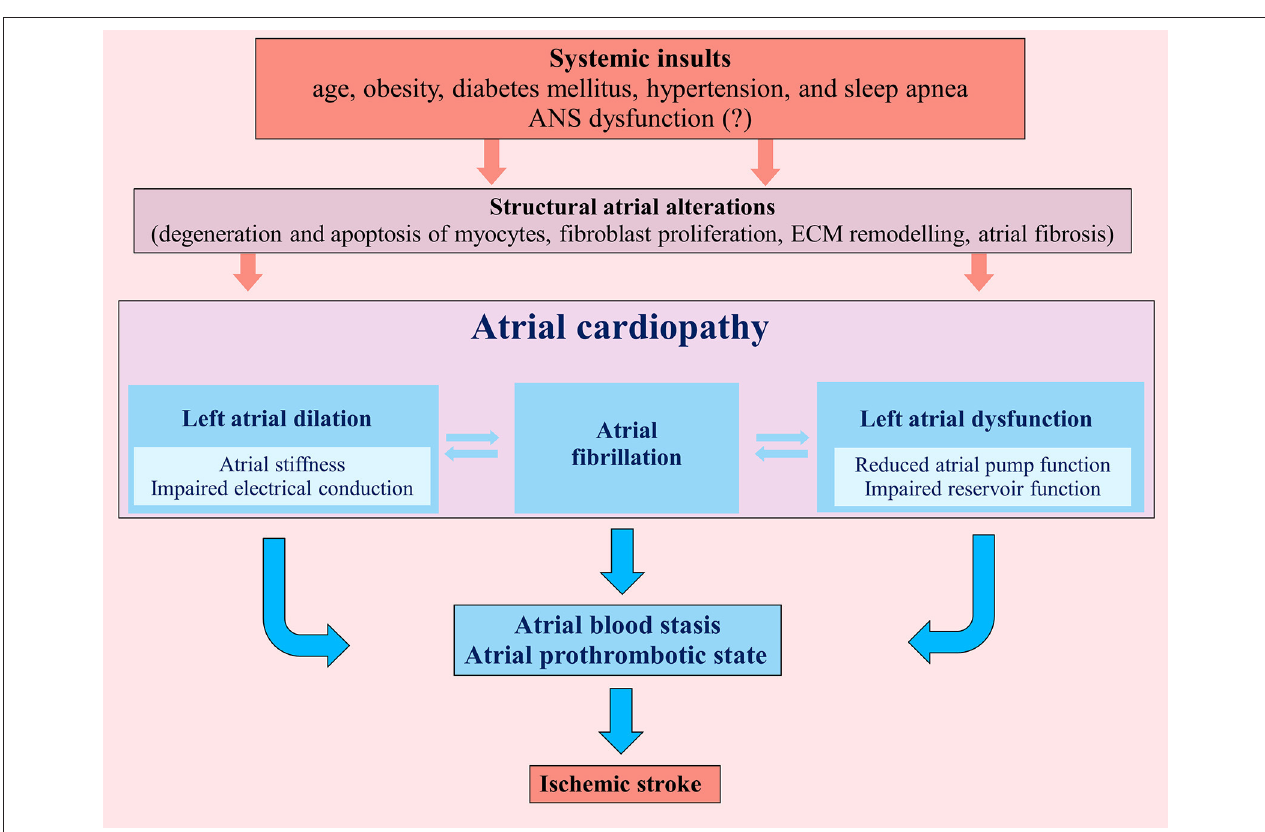
FIGURE 1 | Pathogenic mechanisms determining atrial cardiopathy and favoring an atrial prothrombotic state that can lead to ischemic stroke. ECM, extracellular matrix; ANS, autonomic nervous